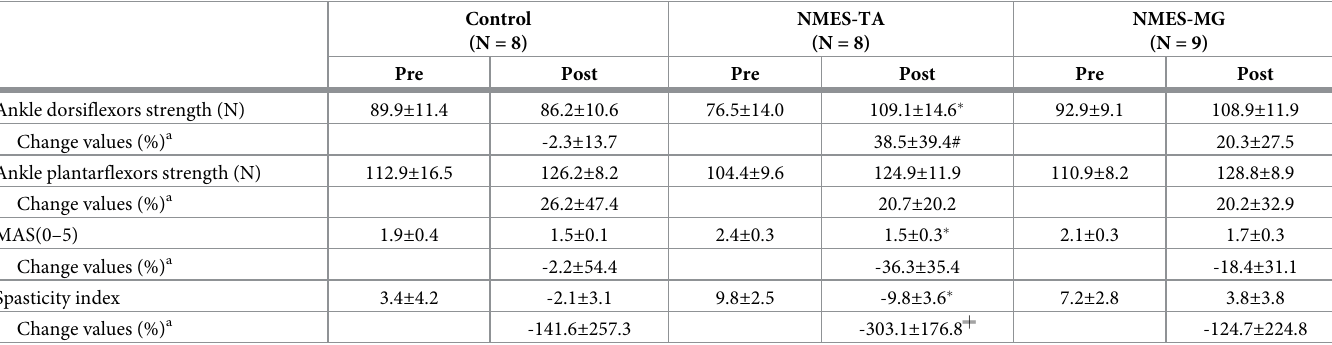
Table 4. Muscle strength and spasticity before and after training in 3